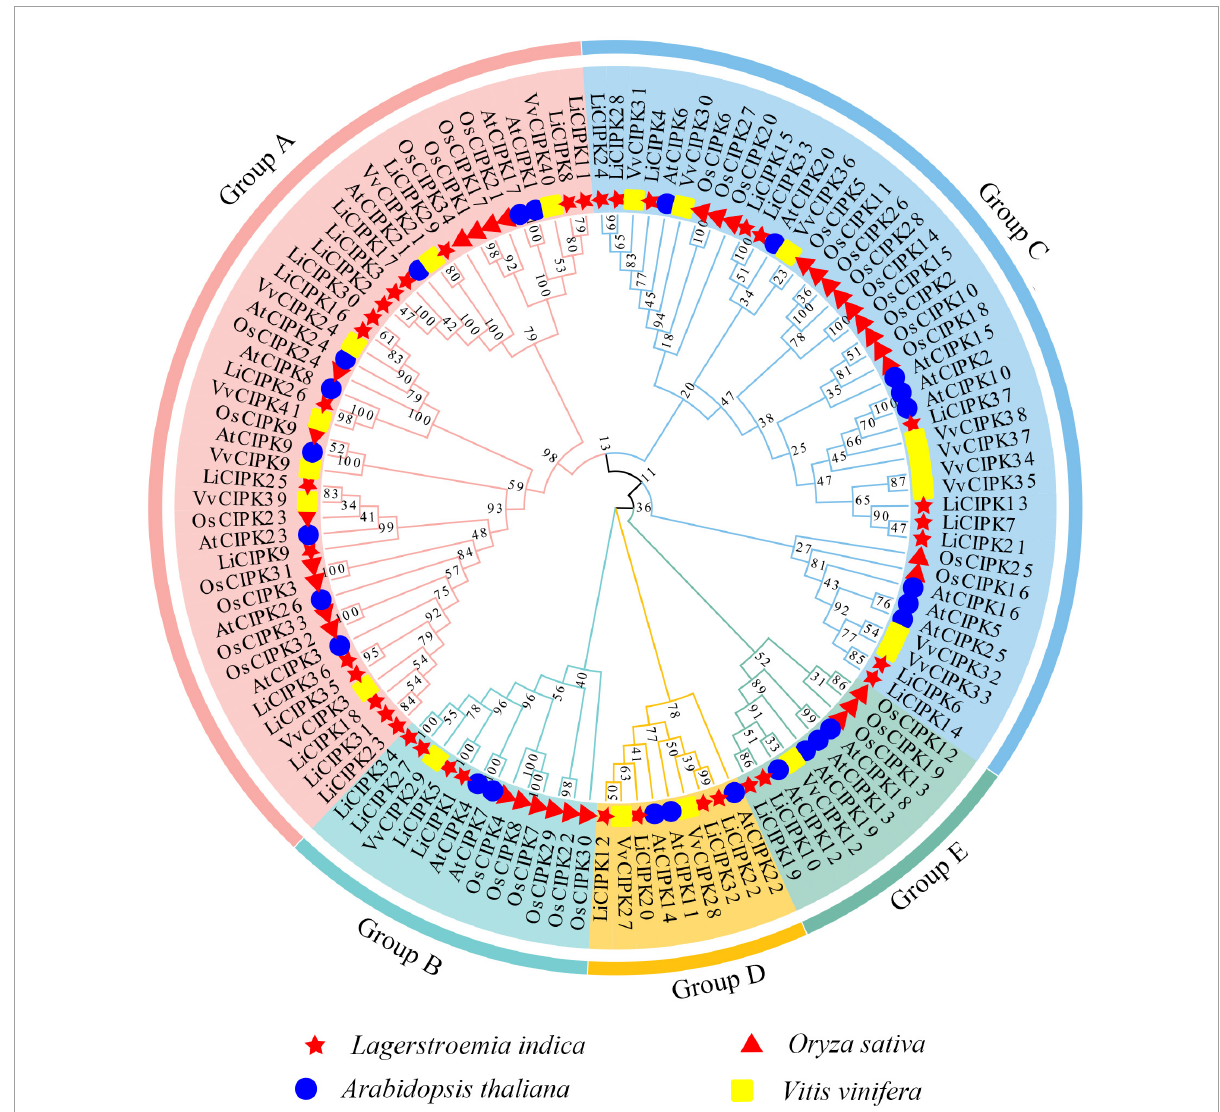
FIGURE3 NJ-Phylogenic tree of AtCIPKs, OsCIPKs, VvCIPKs, and LiCIPKs. The group A to E is shaded by Jade red, Mint cyan, wathet blue, orange, and aquatic green, respectively. Genes of L. indica ( Li ), Arabidopsis thaliana ( At ), Oryza sativ a ( Os ), and Vitis vinifera ( Vv ) are marked by red star, blue circle, red triangle, and yellow rectangle,